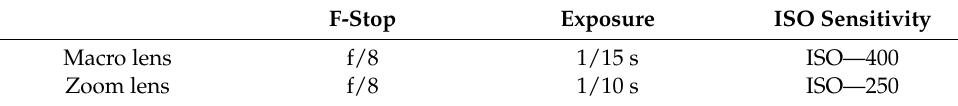
Table 3. Cameras optical